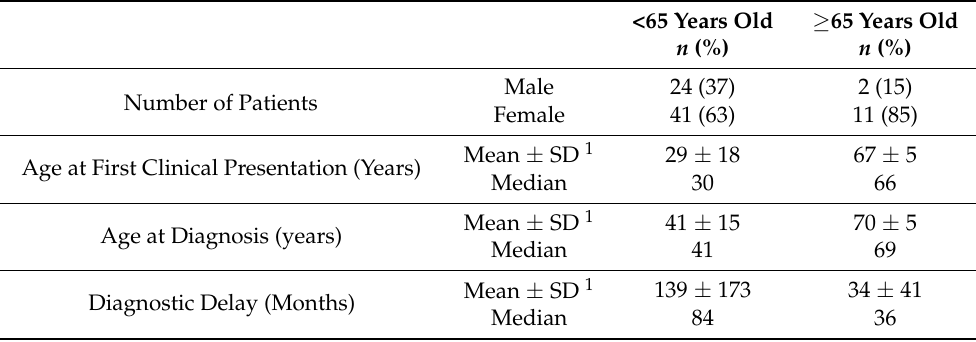
Table 1. Baseline characteristics in 78 younger and older CVID patients.